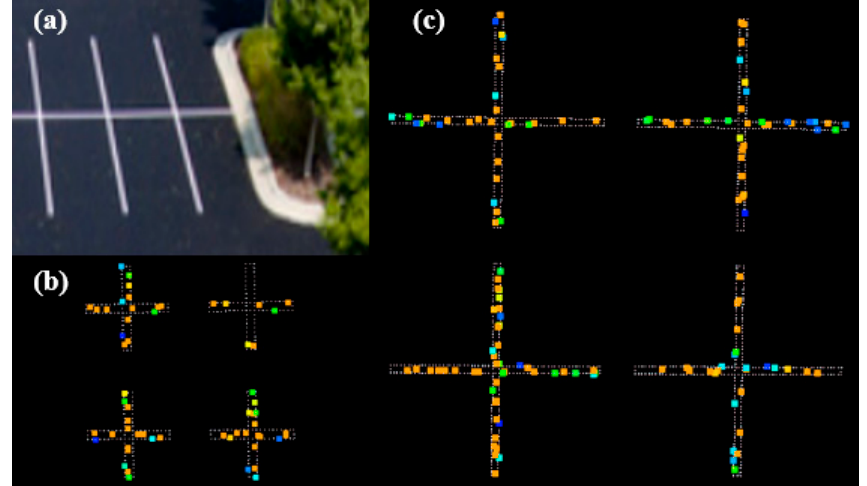
Figure 11. Simulated intensity point cloud on the painted lines on the parking lot: ( a ) Parking lot paint line for 3D accuracy assessment, ( b ) simulated intensity point cloud of the 2 m line, ( c ) simulated intensity point cloud of the 6 m line.